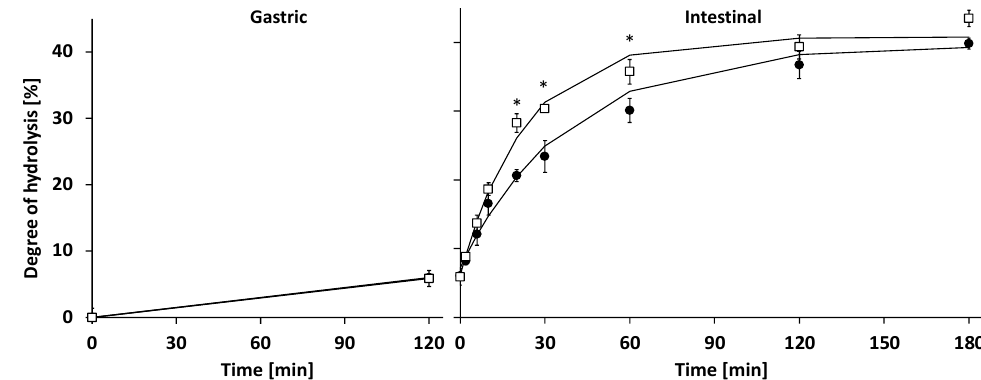
Figure 3. Protein degree of hydrolysis in gastric and intestinal digesta in time. ( • ) Human milk (HM),